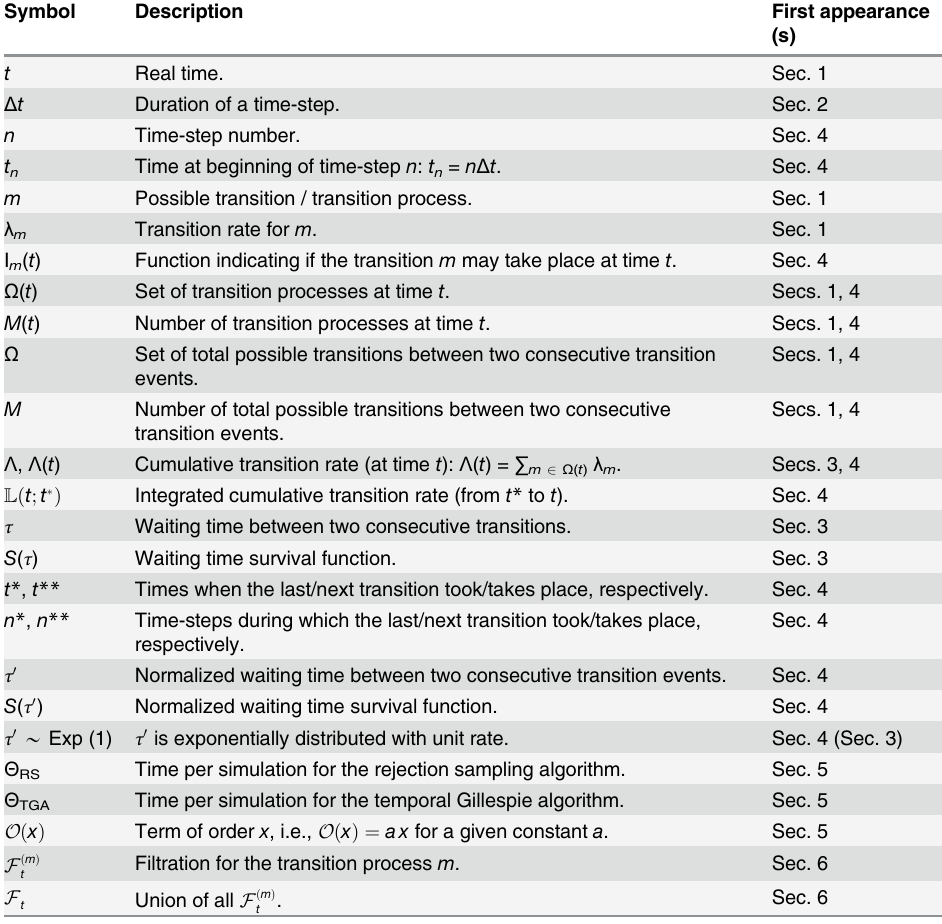
Table 2. Notation pertaining to the temporal Gillespie algorithm. The row “ First appearance(s) ” points to where where the notation is introduced in the Results section. Symbol